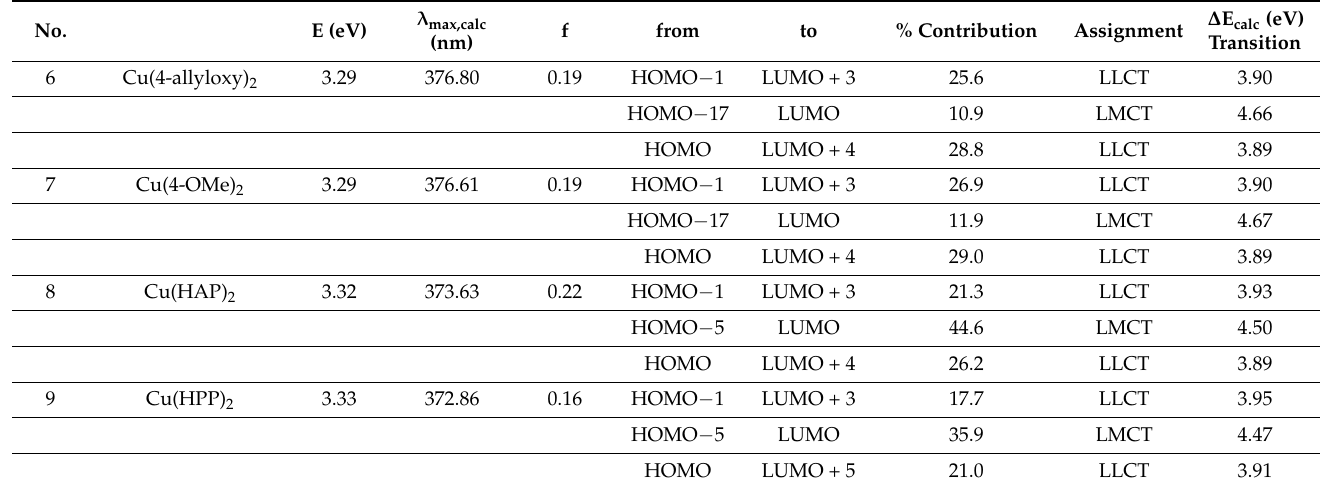
α -NTO particle (left)-hole (right) pair, occ 0.93 β - NTO particle (left)-hole (right) pair, occ 0.73 Figure 6. B3LYP/6-311G(d,p)/def2-TZVPP calculated NTOs involved in the calculated peak at 401.2 nm, corresponding to the experimental peak at 401 nm, of (5). The electron occupation of the occu- pied (particle) and unoccupied (hole) NTO pairs are indicated. A contour of 0.04 e/Å 3 was used for the orbital plot. Colour code of atoms (online version): Cu (orange), C (grey), O (red), H (white).